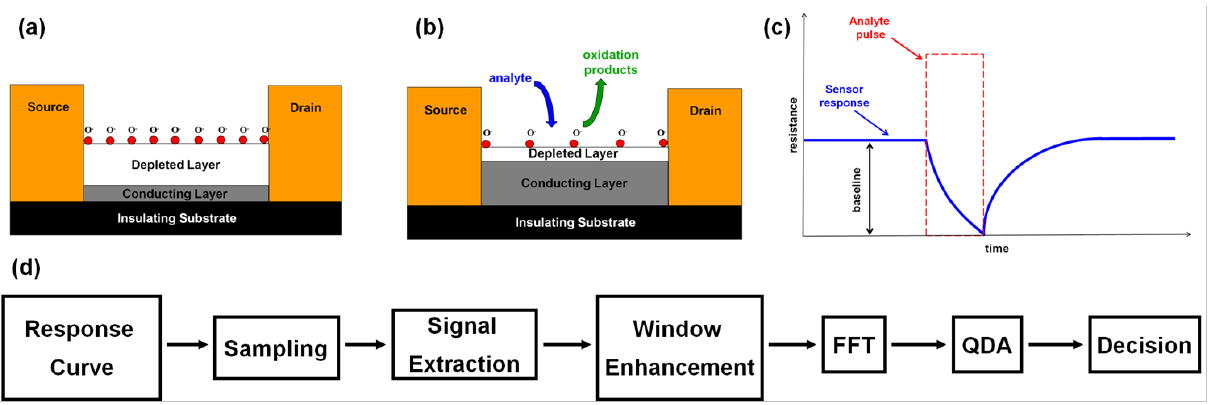
Figure 1. ( a ) Schematics of a thermally activated metal oxide chemiresistor of